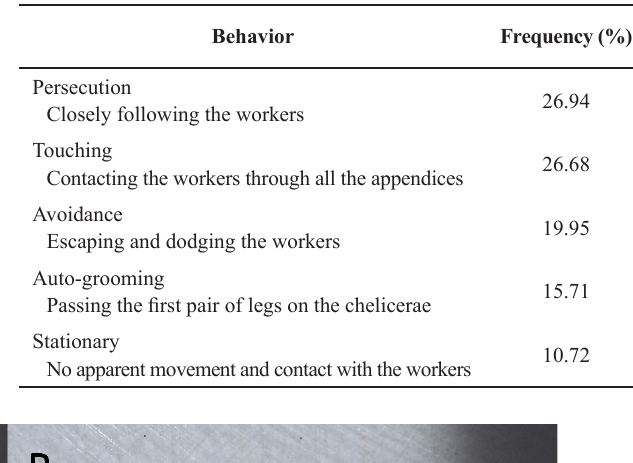
Table 1 . Frequency of behaviors exhibited by Attacobius lavape inside fire ant colonies Solenopsis saevissima and Solenopsis invicta in laboratory.